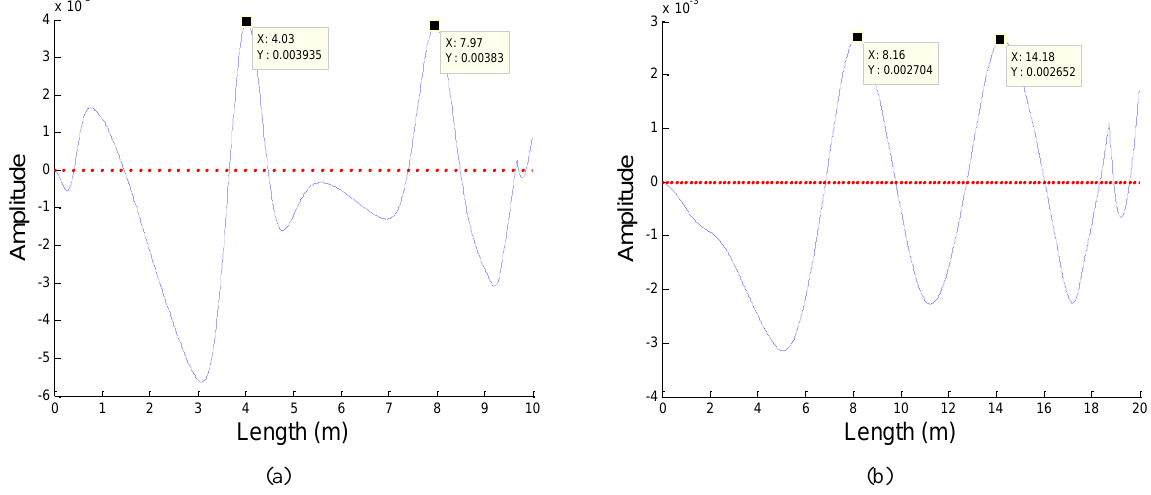
Fig. 10. IMF 1: (a) δ = 0.3 at 4 m and 8 m for beam length of 10 m, (b) δ = 0.3 at 8 m and 14 m for beam length of 20 m.